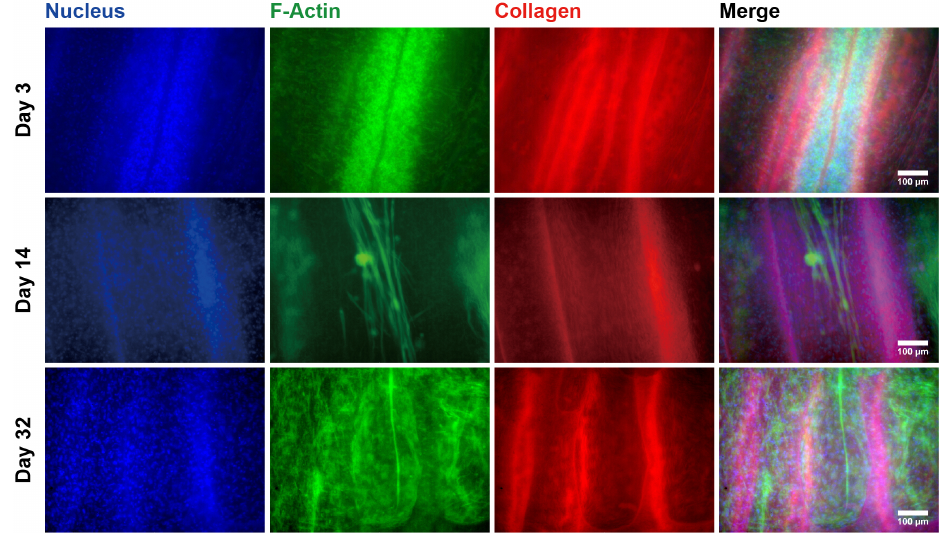
Figure 2. Fluorescent images of myotubes in the micro-channels of the MCCG.